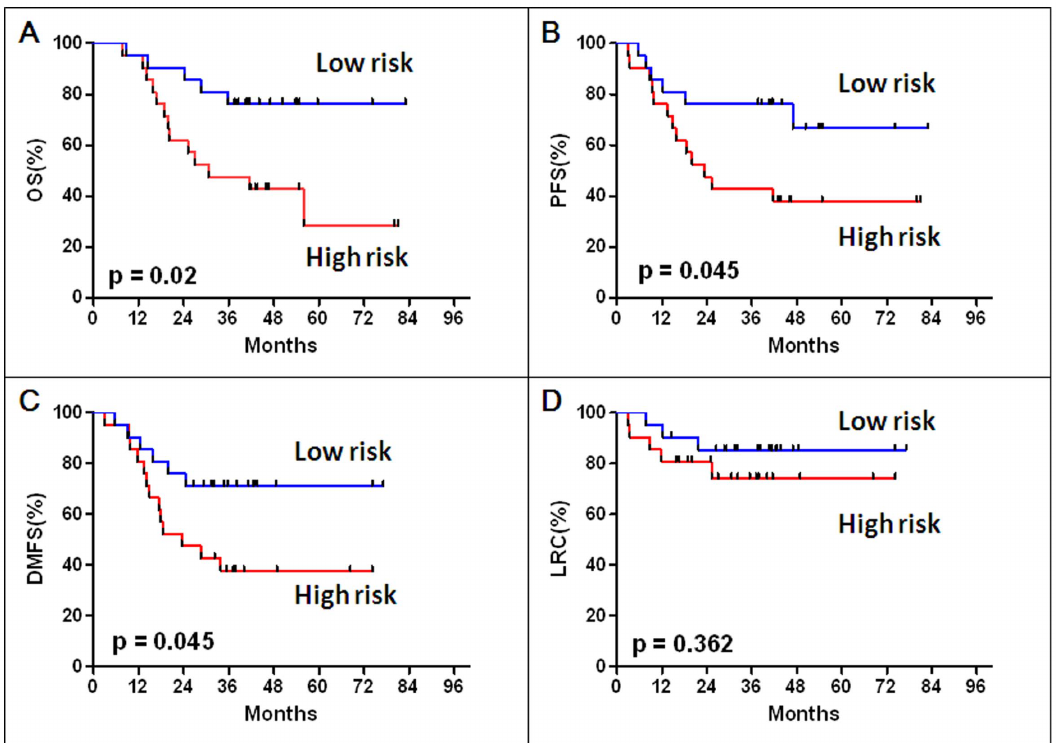
Figure 2. Kaplan-Meier analyses of overall survival (OS), progression-free survival (PFS), distant metastasis-free survival (DMFS) and local-regional control (LRC) according to the microRNA signature in the training data set (42 SCLC patients).